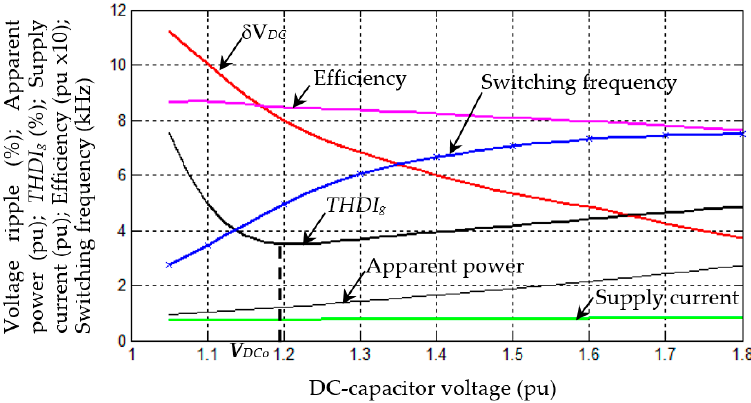
Figure 2. Total harmonic distortion factor of the supply current − THDI g (%), apparent power of the direct current (DC)-capacitor − S DC (pu), phase supply current − I g (pu), amplitude of DC-voltage ripple − δ V DC (%), total efficiency (pu ×10) and average switching frequency versus the DC-capacitor voltage (pu).